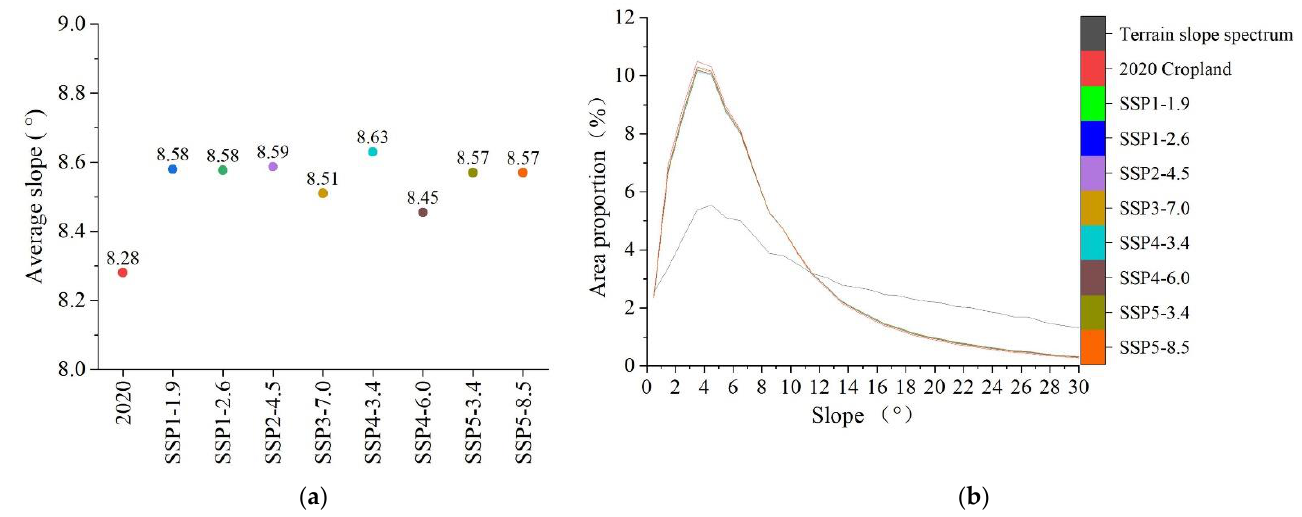
Figure 7. Average slopes and slope spectrum of cropland in the MRYRR in 2035 under different scenarios. ( a ) Predictions of the average slopes in 2035. ( b ) Slope spectrum of cropland in 2035.